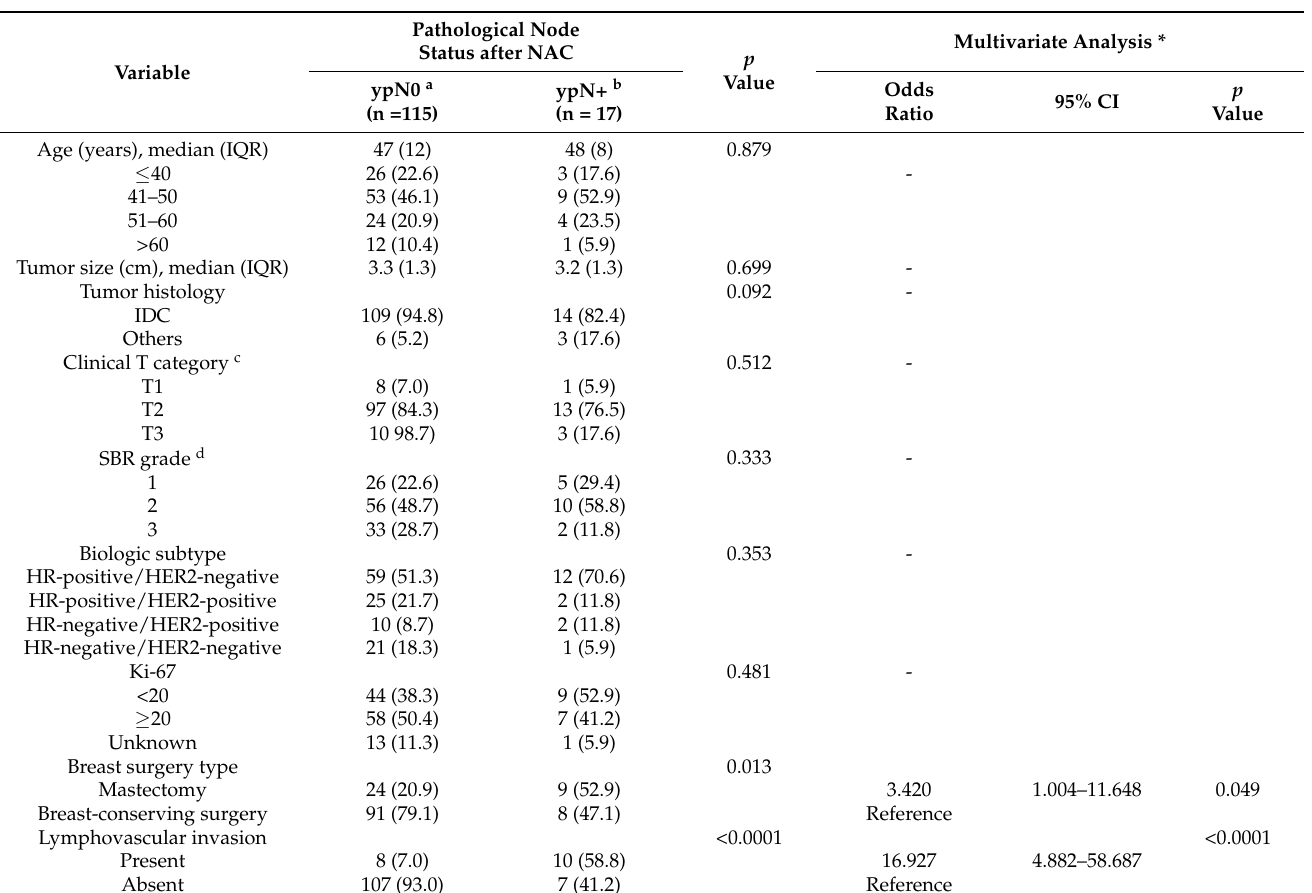
Table 4. Univariate and multivariate analysis of factors influencing the lymph node status in the subgroup patients with breast non-pCR after